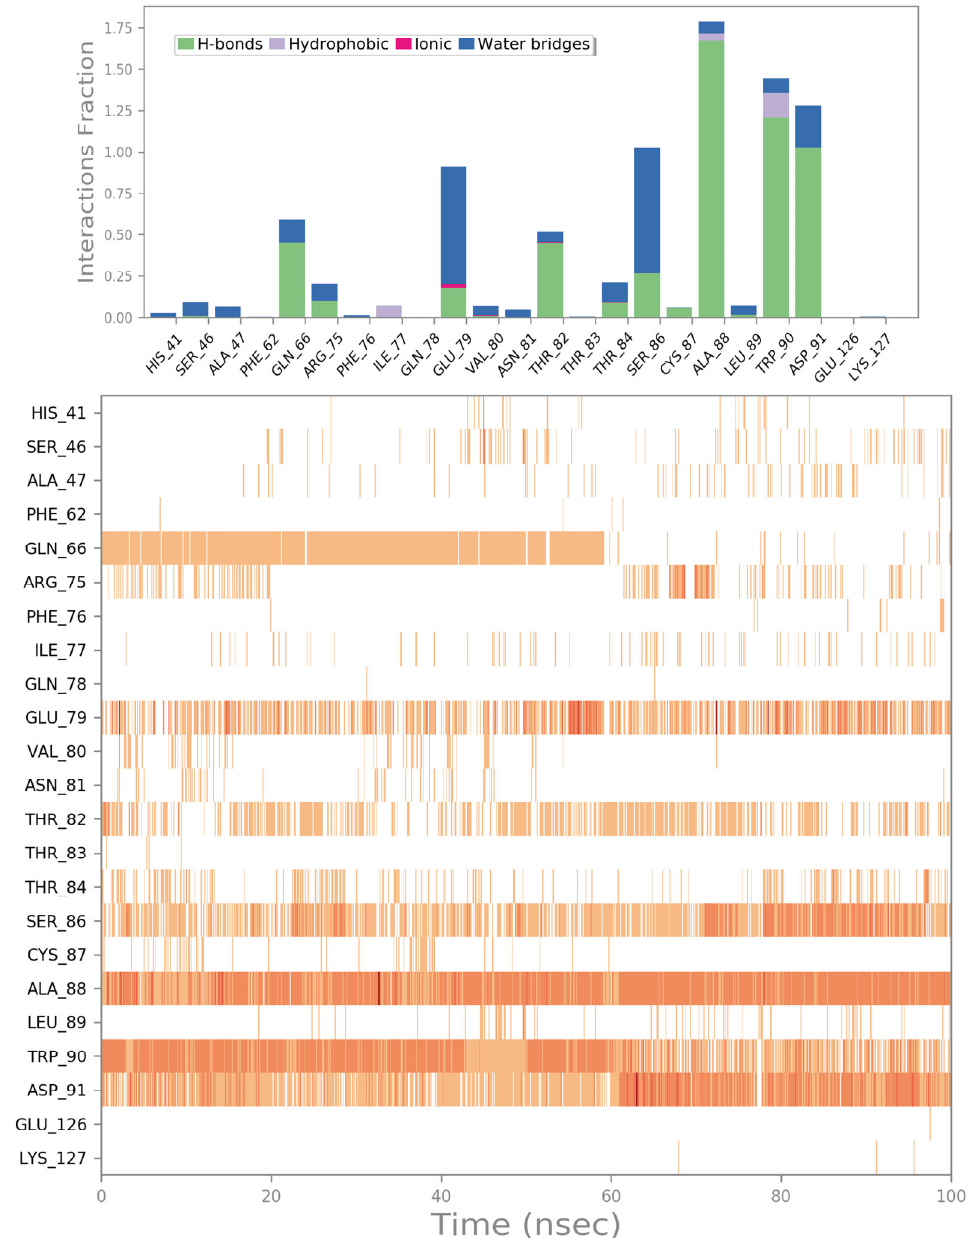
Figure 4. ZINC000003830946 monitored during the MD run. The interactions can be grouped into four types: H bonds (green), hydrophobic (grey), ionic (magenta), and water bridges (blue). The subsequent diagram in the fi gure illustrates a timeline description of the main interactions. A darker hue of orange indicates that some residues make many distinct contacts with the ligand (Maestro, Schrödinger LLC, release